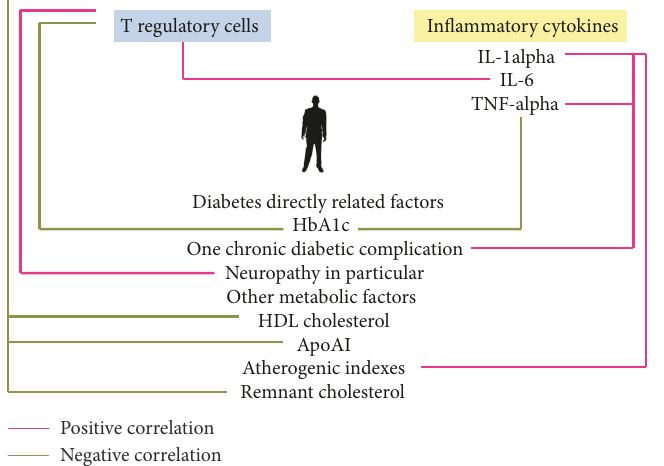
Figure 11: Regulatory T cell count positively correlated with the presence of neuropathy and with IL-6 level. Negative relationship was observed between regulatory T cell count and HbA1c level, HDL, ApoAI, and remnant cholesterol. IL-1alpha level was positively connected with the presence of one chronic diabetic complication (the same stands for TNF-alpha) as well as to calculated atherogenic indexes. We observed a negative relationship between TNF-alpha and HbA1c